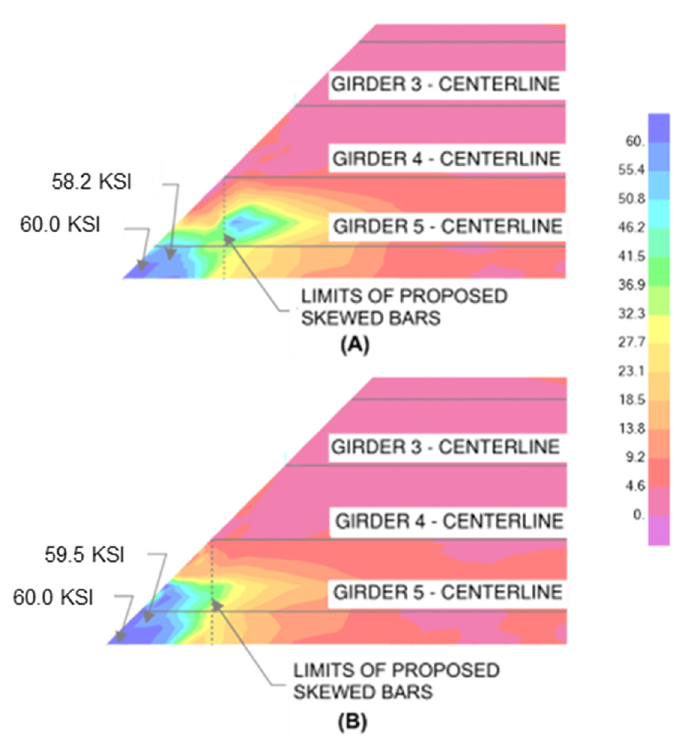
Figure 15. The stress distribution (ksi) in the top transverse reinforcement for Design Case 1 with